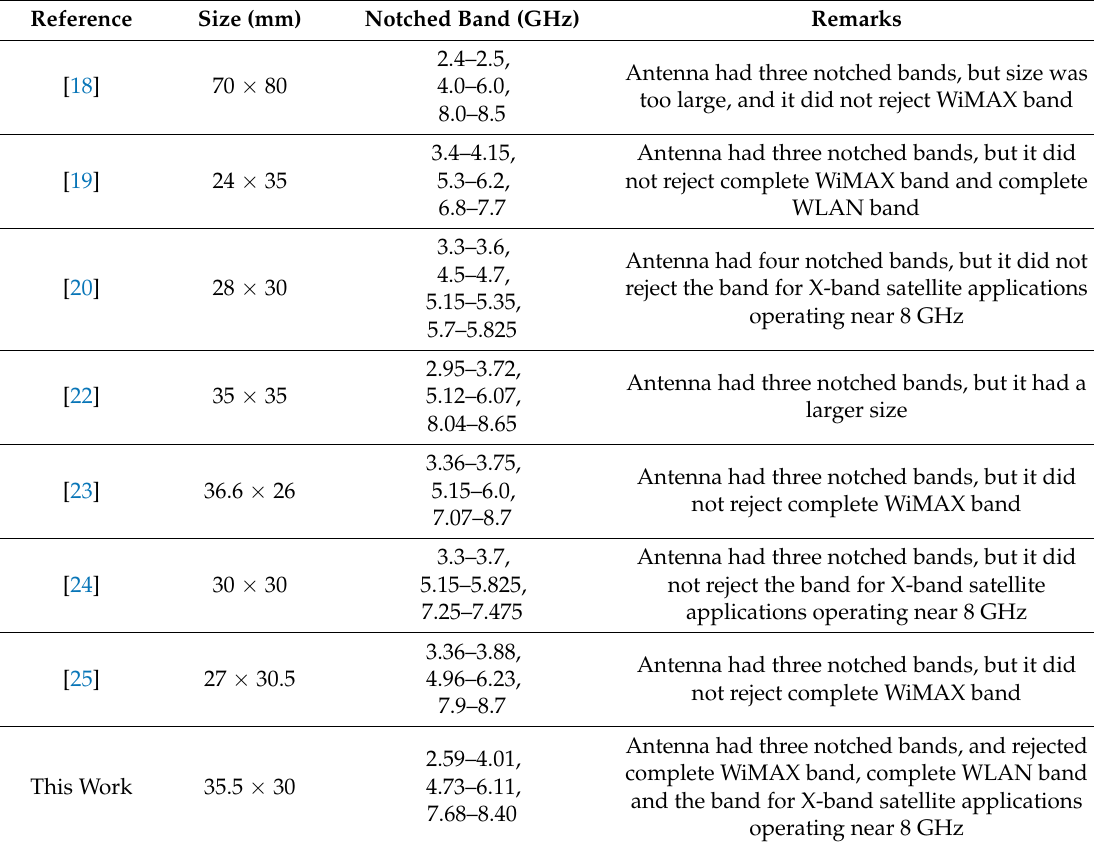
Table 3. Comparison between proposed and reported UWB antennas with band-notched